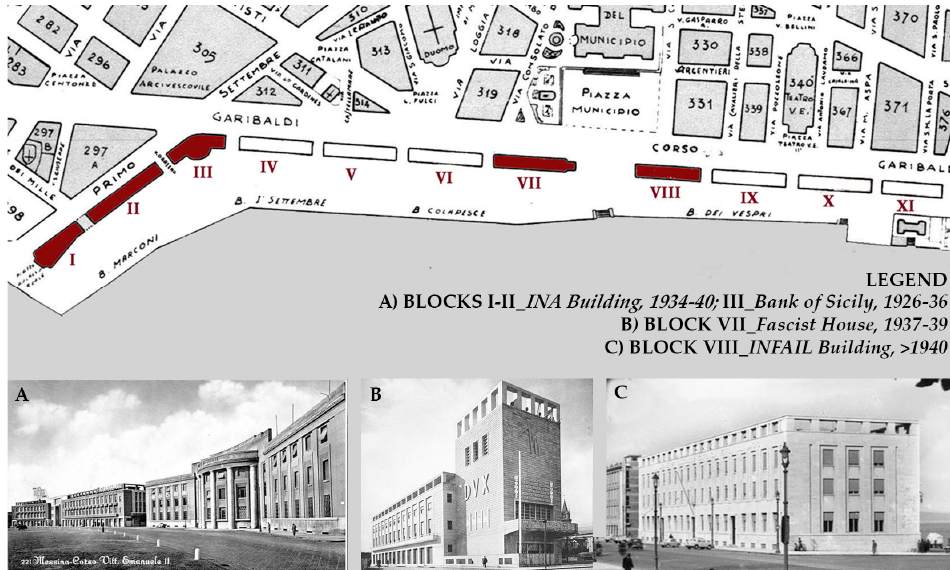
Figure 4. The sea front in 1943: the Palazzata under construction. Author processing/Private collection.